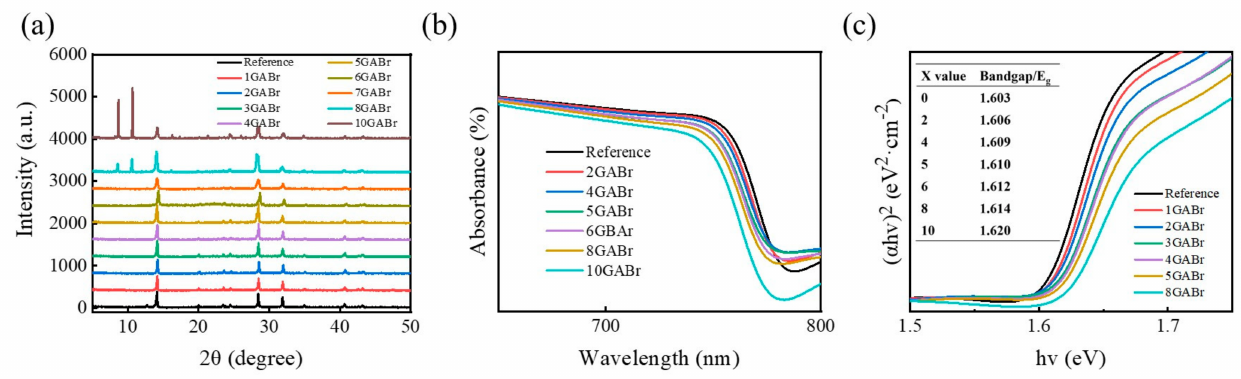
Figure 1. ( a ) XRD patterns of pristine MAPbI 3 and perovskite films, ( b ) the UV-vis absorption spectra, and ( c ) ( α hv) 2 versus energy of perovskite films, treated by GABr with different